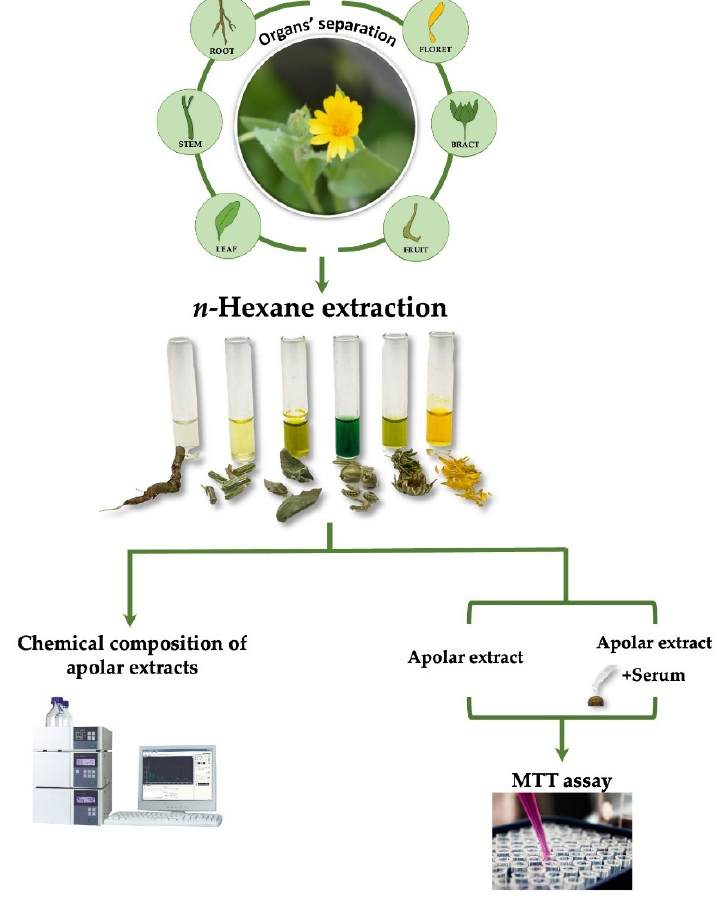
Figure 8. Calendula arvensis scheme of methodological steps: organs’ separation and extraction in n -hexane followed by chemical composition analysis and cytotoxic assessment of the extract and enriched serum.